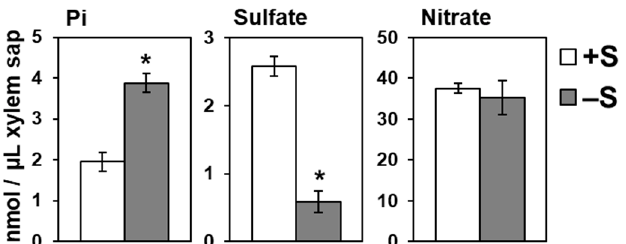
Figure 3. Increased Pi levels in xylem sap under –S. Wild-type (WT) plants were used. Twenty-day-old plants were transferred to hydroponic media supplemented with 1500 µM sulfate (+S) for 2 days before starting the treatment. For the treatment, plants were transferred to hydroponic media with (+S, white bar) or without (–S, gray bar) sulfate. Xylem sap was collected from decapitated stem after cutting the main stem when the main stem height reached approximately 3 cm for all plants. Bars and error bars indicate mean ± SE ( n = 3). Asterisks indicate significant differences between +S and –S detected by Student’s t -test (* p < 0.05).